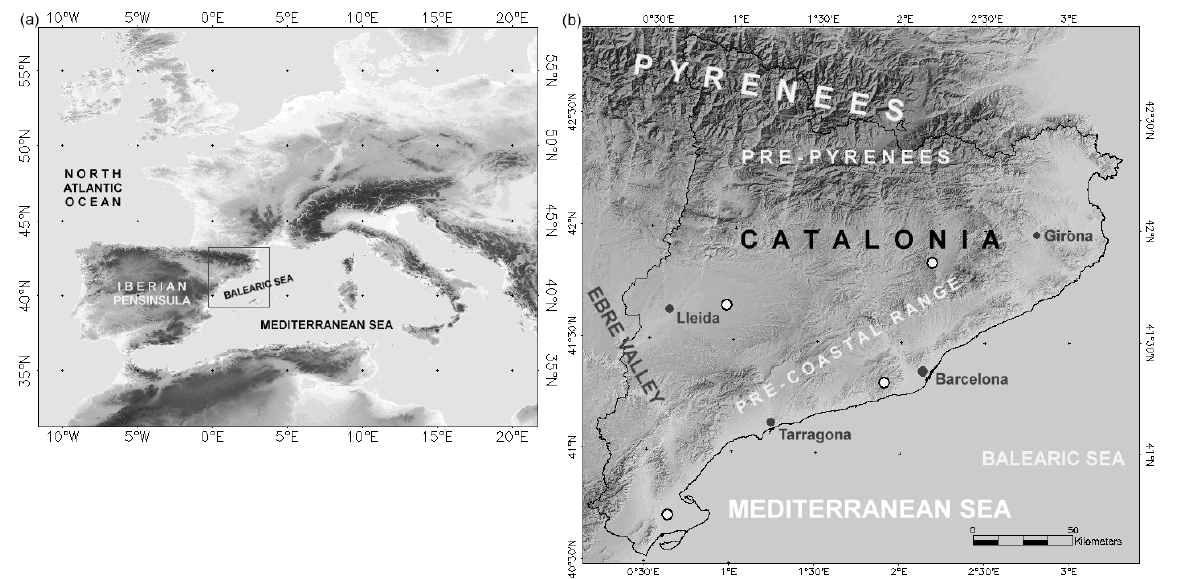
Figure 1. (a) Location of Catalonia, the area of study, situated NE of the Iberian Peninsula and in the western Mediterranean basin. (b) Shaded relief of Catalonia showing significant geographic features, the location of the SMC-LLS detectors (white circles) and the Barcelona sounding station (N41 ◦ 23 (cid:48) 4.08 (cid:48)(cid:48) E2 ◦ 7 (cid:48) 3.36 (cid:48)(cid:48) – N ◦ WMO: